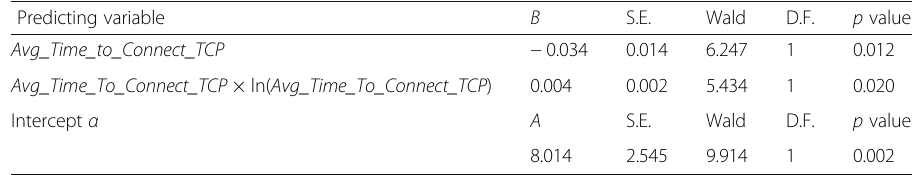
Table 7 Testing linearity assumption Predicting variable